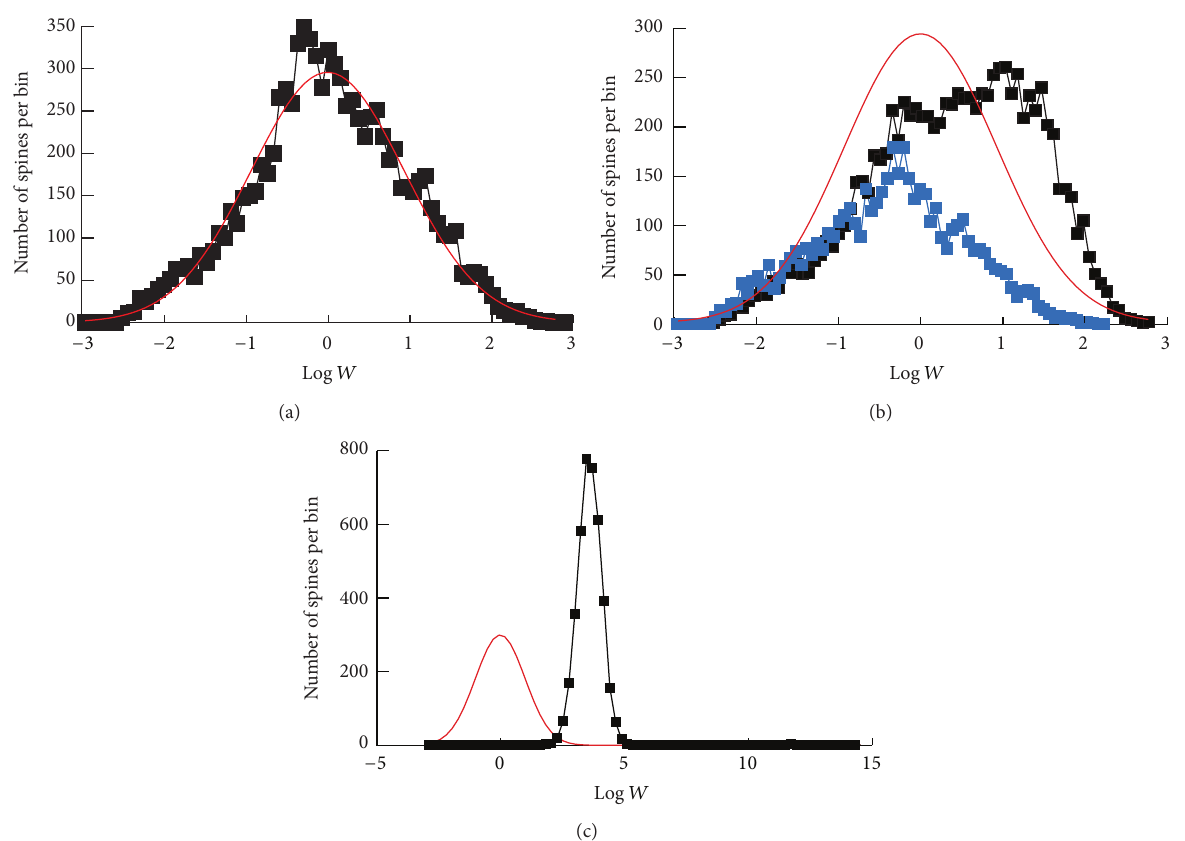
Figure 2: Simulated distributions of synaptic weights. (a) Distribution for 1,000 independent clusters with 𝑁 cl = 10 . Black trace, histogram with 80 bins illustrating an approximately log-normal distribution of the 10,000 weights. Each bin is equal in width in natural log units. Red curve, a log-normal distribution (mean at 0.0131, standard deviation of 0.9341), fitted by MATLAB, that approximately reproduces the histogram. The histogram was constructed after 50,000 simulated days to ensure a steady state. (b) Black and red traces, similar to (a), except the mean and standard deviation of LTP, parameters 𝑎 1 and sd 1 , are fixed at 0.16 and 0.04, respectively. Blue trace, the histogram of 𝑊 is shifted to much lower values when 𝑎 1 is decreased by 2%. (c) Weight dynamics without regeneration of synapses. The histogram of the active synapses shifts to much greater values (black trace). ∼ 45% of synapses are silent, unable to regenerate, and not included in the histogram. This histogram is an approximate steady state, although with no regeneration, all synapses would become silent after a much longer time. Red curve, normal distribution from